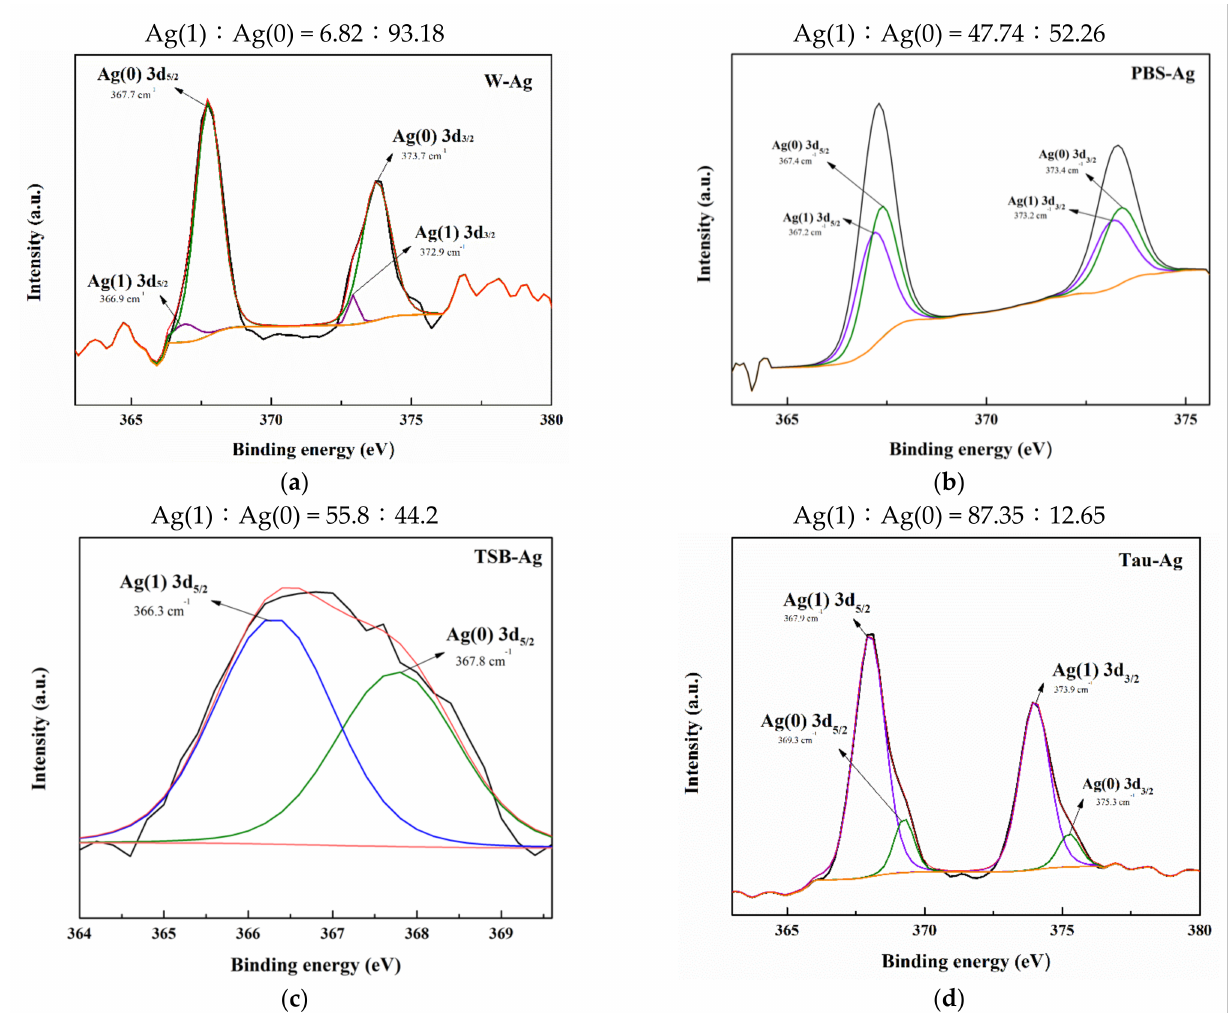
Figure 2. XPS results of ( a ) W-Ag, ( b ) PBS-Ag, ( c ) TSB-Ag, and ( d ) Tau-Ag patterns. TSB-Ag and Tau-Ag, two matrixes possessing higher contents of silver ions, were further observed by TEM (Figure 3). For TSB-Ag, it was shown that larger AgNPs were coalesced and incorporated in the structure of the protein (Figure 3a). By contract, Figure 3b shows that the AgNPs in Tau-Ag were present in a low content, were uniformly distributed, and had smaller sizes. No observable particle was seen in the micrographs of W-Ag and PBS-Ag (data not shown). Given the observations of Tau-Ag, a higher surface area could be expected, which would lead to more partial oxidation of silver and result in a